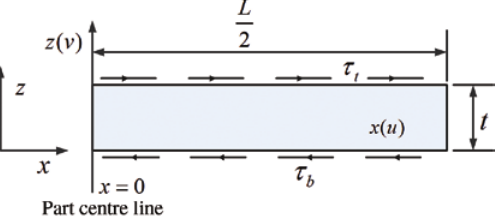
Figure 2: Schematic of a beam under applied shear tractions on the top and bottom surfaces.